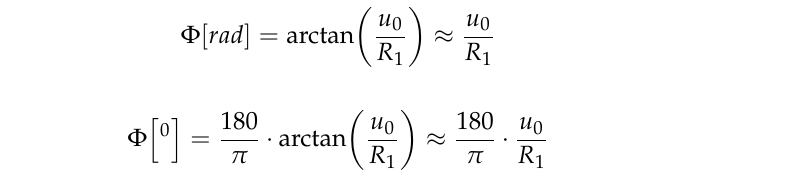
(cid:2) 0 (cid:3) Figure 12. The u [ mm ] horizontal and the corresponding Φ angular (torsional) displacements’ graphs     mmu 0  angular (torsional) displacements’ for P 0 (red line) and P 1 (green line) during one complete cycle vs. the captured images number. Figure 12. The horizontal and the corresponding P (green line) during one complete cycle vs. the captured images P (red line) and graphs for Taking an u [ mm ] magnitude value (better/it is recommended) of u 0 of the point P 0 , 1 0 (cid:2) 0 (cid:3) number. the corresponding Φ angular amplitude will